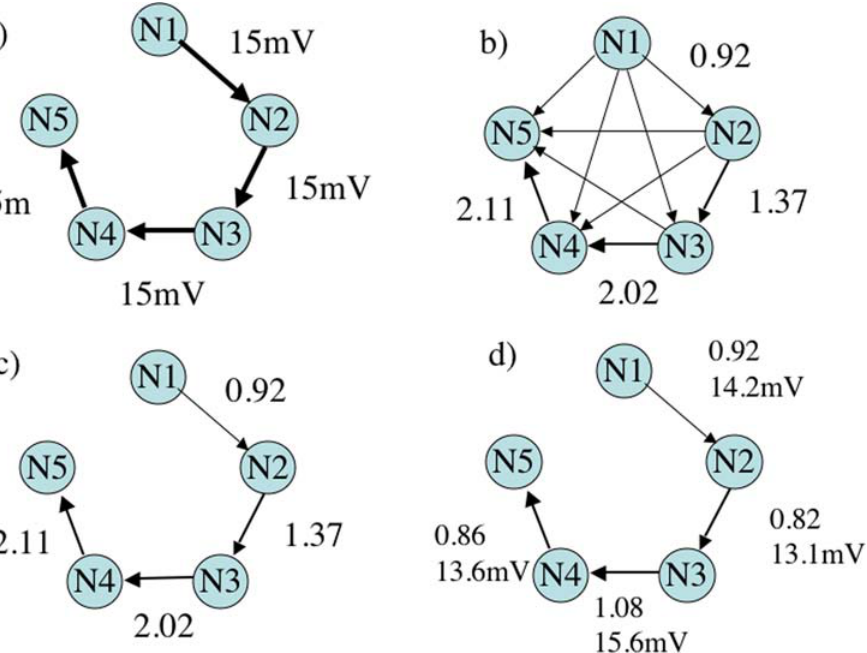
Figure 5. Application of Pairwise and Conditional Granger Causality Analysis to a Five-Neuron Serial Chain. This was carried out where a) shows the synaptic weights before simulation. Calculation of PGC for all possible connections for the 5 neurons yields the plot shown in b). Notice that using PGC alone many new false connections are shown. When CGC is used to eliminate the false connection the plot is reduced to what is shown in c). After CGC plot c) begins to resemble the connectivity pattern as shown in a), however, the values associated with c) do not scale with the synaptic weights shown in a). A further step using CGC a second time or using Geweke’s subtraction method is required to detangle direct and mediated influences. The results after the use of Geweke’s subtraction method to calculate DGC are shown in d) along with corresponding